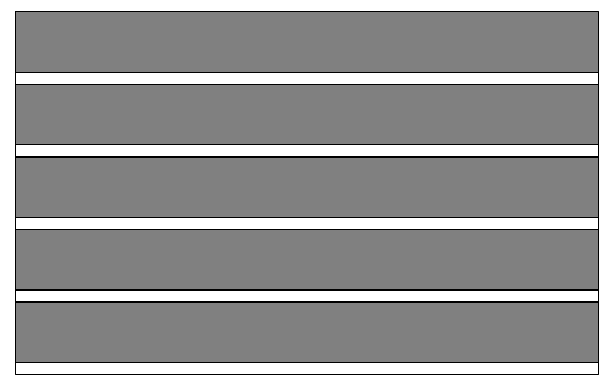
Figure 11. Textile thought for areas detection.